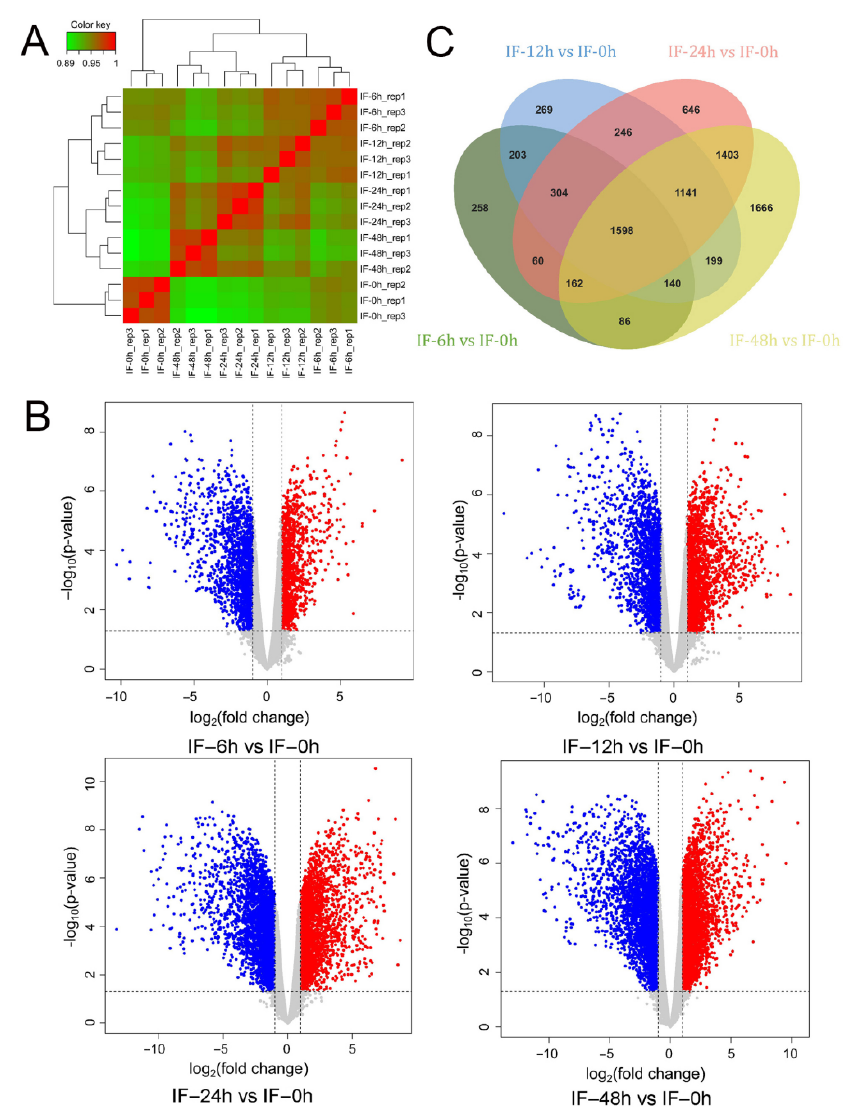
Figure 1. Comparison of gene expression and differentially expressed genes (DEGs) during the early infection stage of P. sojae to soybean leaves. ( A ) Hierarchical clustering analysis (HCA) of transcriptome data from 15 samples during the early infection. Color scale ranging from green to red indicates the inter-sample correlation from low to high. ( B ) Volcano plots illustrating the DEGs at different sampling time points after the inoculation of P. sojae to leaves. ( C ) Venn diagram showing the DEGs identified from comparison of 6, 12, 24 and 48 hpi with 0 hpi.